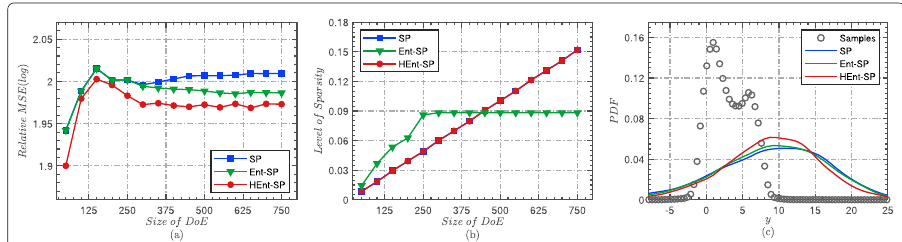
Fig. 8 Performance comparison of SP, Ent-SP and HEnt-SP w.r.t. the OAKLEY & O’HAGAN function. ( a ) The relationship between the relative MSE and the size of DoE; ( b ) The relationship between the sparsity level of